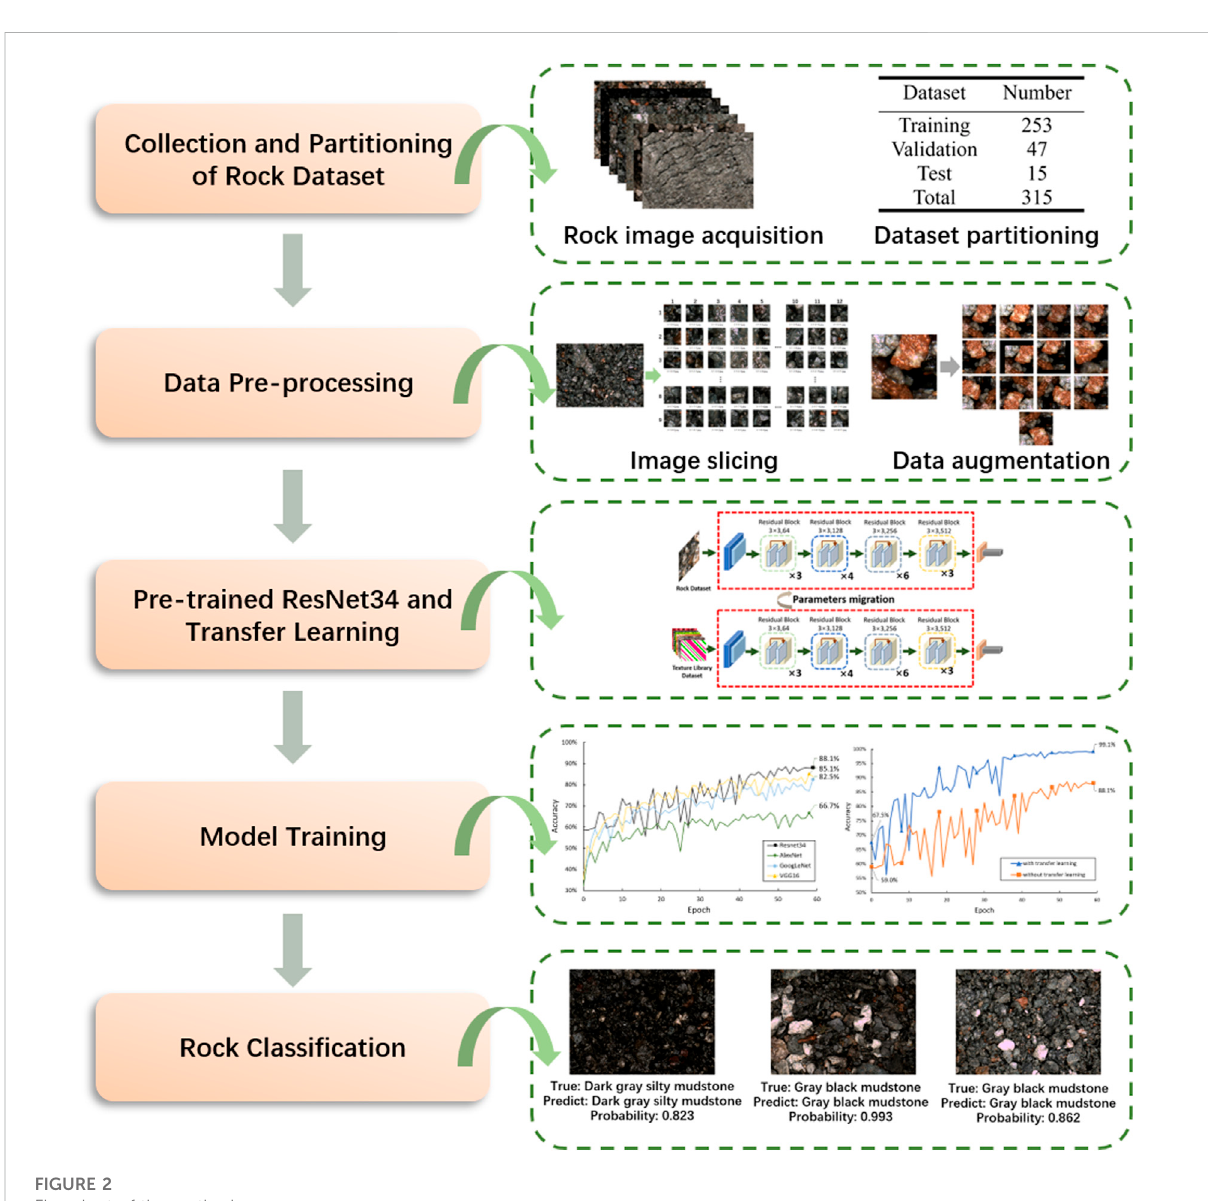
FIGURE 2 Flowchart of the